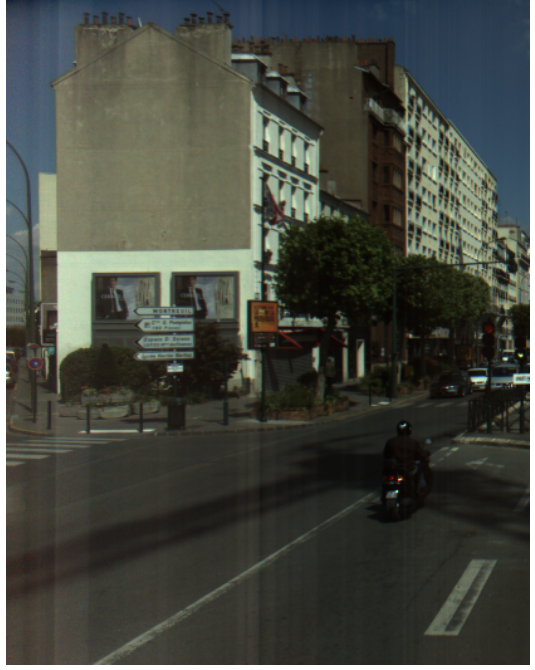
Figure 3: Image affected by a strong vertical smear, because of a worn-out